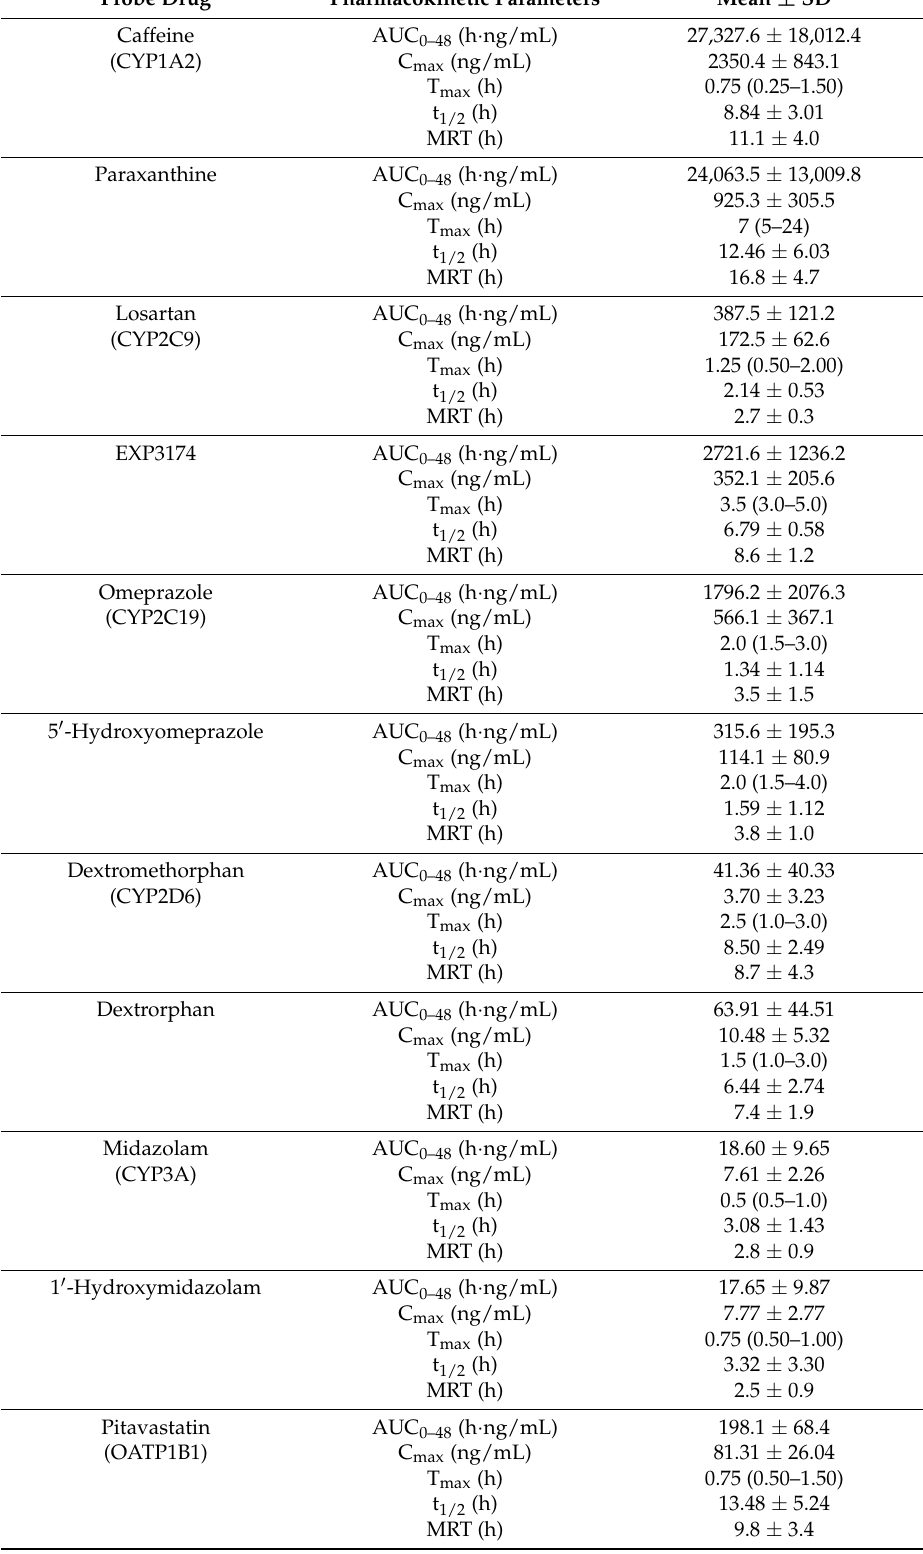
Table 5. Summary of pharmacokinetic parameters of organic anion transporting polypeptide 1B1 (OATP1B1) and cytochrome P450 (P450) probe drugs and their metabolites ( n = 6). Results are expressed as mean ± SD or median